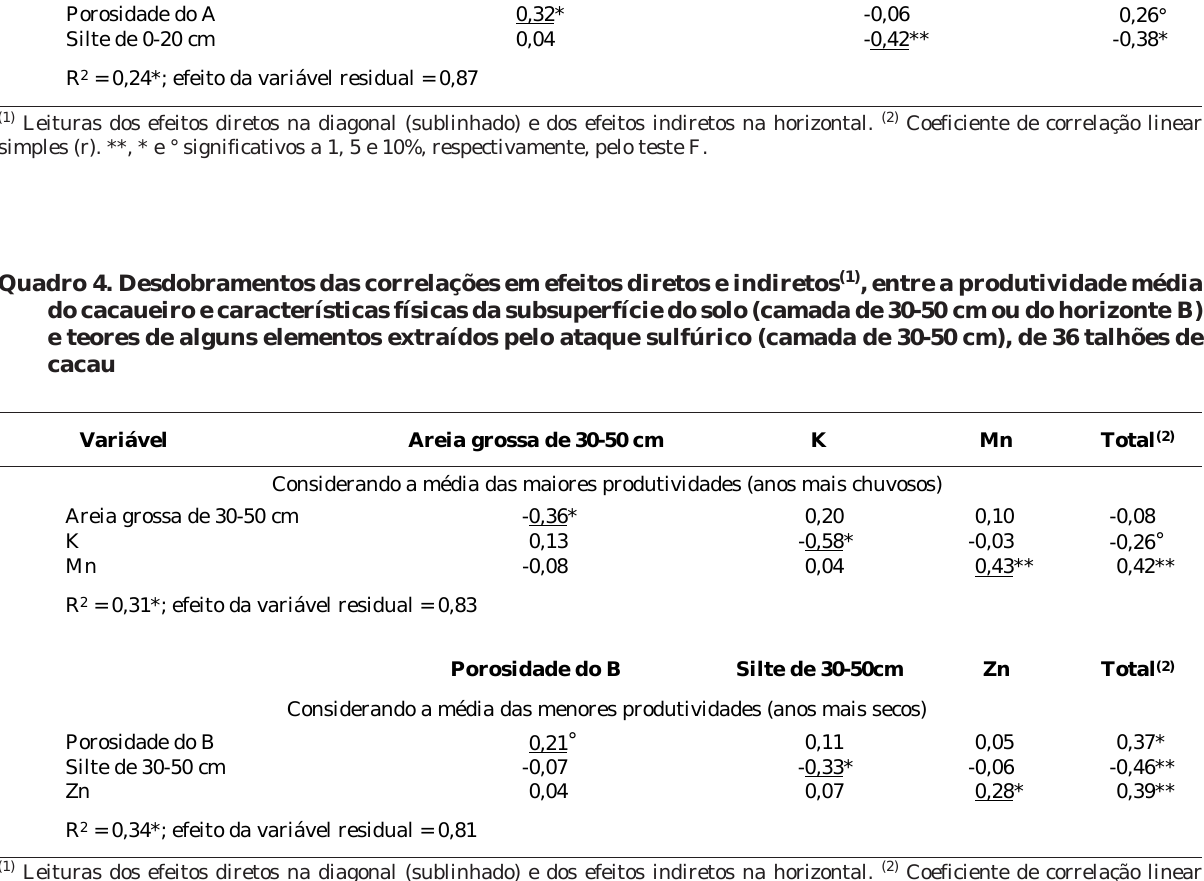
sinônimos de horizontes menos densos, e mais propícios para o desenvolvimento do cacaueiro (Yaw, 1981). Para os anos mais chuvosos, a textura da camada de 0-20 cm não apresentou efeitos, direto ou total, significativos (p > 0,10) sobre a produtividade. Já a areia grossa da camada de 30-50 cm apontou efeito direto, significativo e negativo, nas maiores